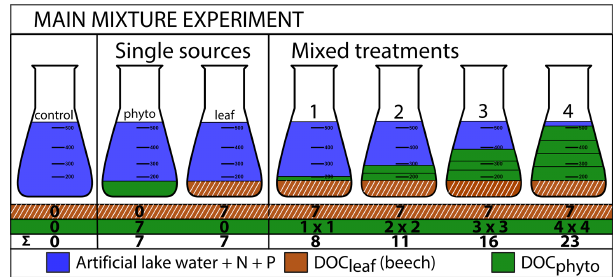
Fig. 1. Experimental setup for the main mixture experiment with controls (left), single-source incubations (middle), and mixed treat- ments (right) with pulses of DOC phyto 1 to 4. At the bottom, the brown striped line gives the amount of added DOC leaf (7mg CL − 1 ) , the green line the amount of DOC phyto and numbers of pulses, and the white line at the bottom the sum of DOC added. All units are given in mg CL − 1